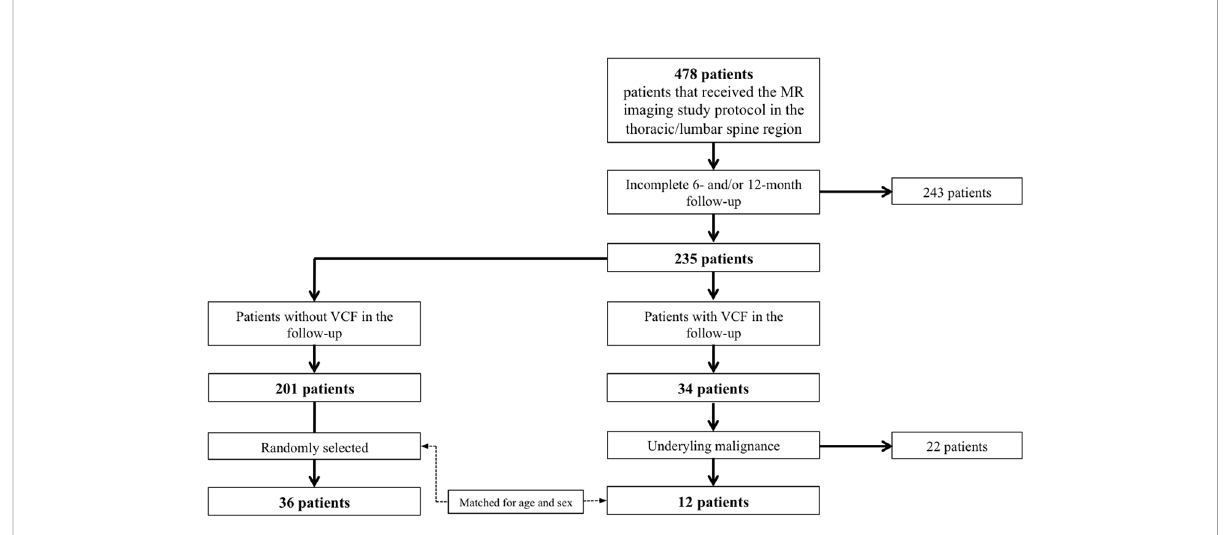
FIGURE 1 Flowchart of patient